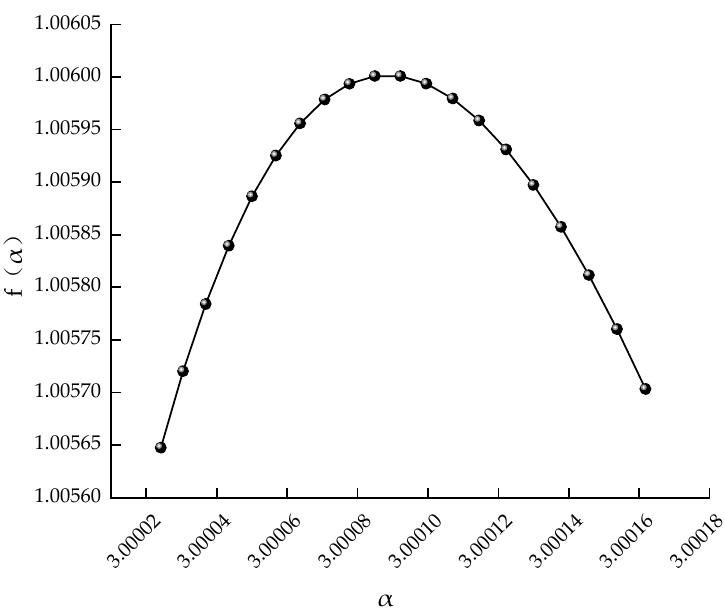
Figure 2. The generalized fractal spectrum of time series.